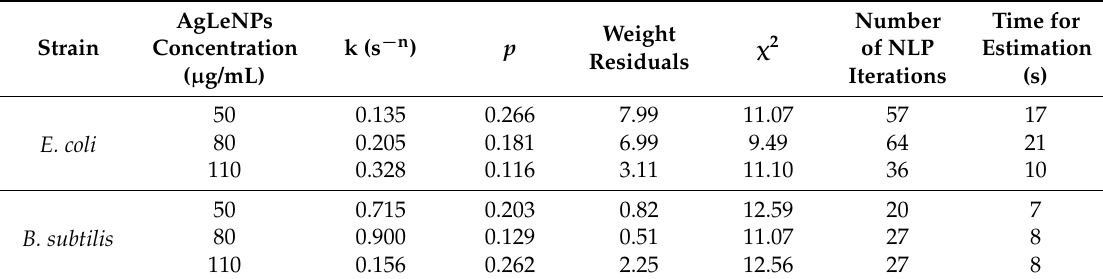
Table 1. Parameters estimated and statistical